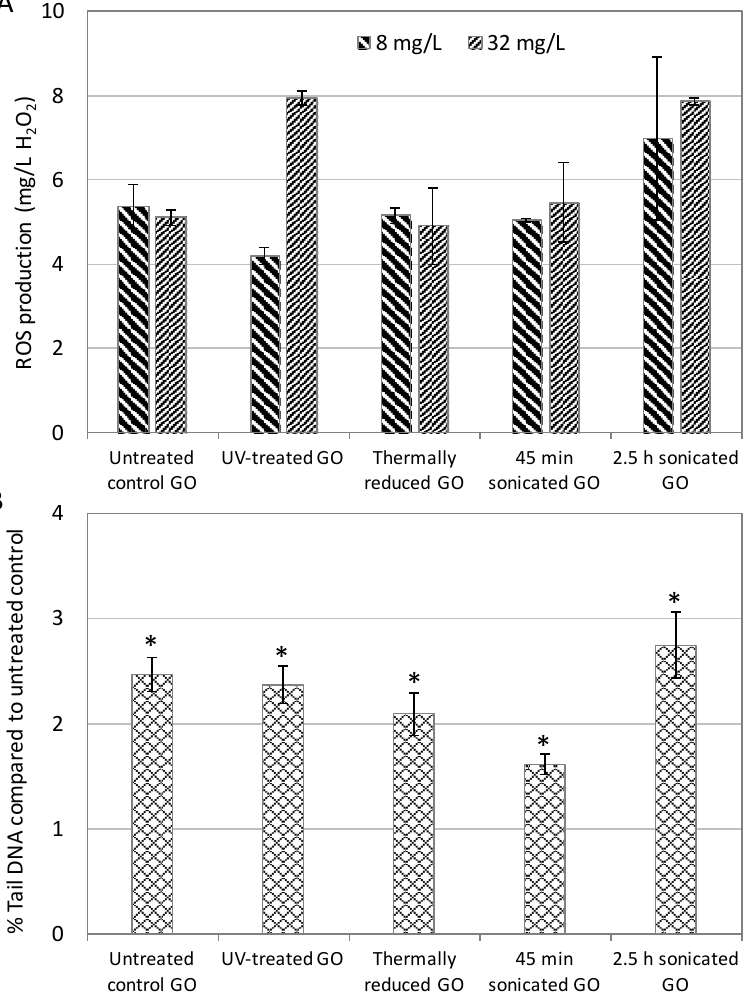
Figure 4. ( A ) Intracellular reactive oxygen species (ROS) production (equivalent to mg/L H 2 O 2 ) in yeast cells induced by the 5 tested graphene oxides (GOs), and ( B ) % Tail DNA compared to the untreated control determined by the alkaline comet assay for the 5 GOs. The % Tail DNA compared to the untreated control indicates DNA damage caused in human A549 cells by the 5 GOs. ( A ) and ( B ): X-axis bottom: name of the 5 GOs; Y-axis: ( A ) ROS production (equivalent to mg/L H 2 O 2 ), and ( B ) % Tail DNA compared to the untreated control. The “*” indicates a significant difference from the untreated control ( p < 0.05). Mean ± SD. For ROS production, n = 3; for comet assay, n = 4.